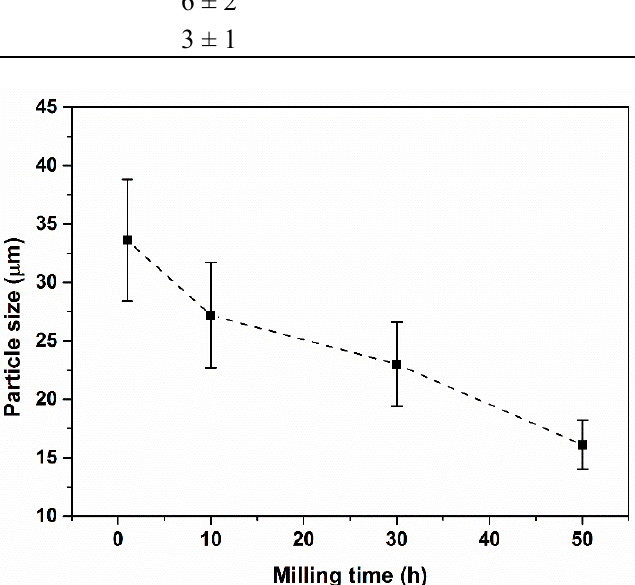
Figure 9. Average particle sizes of the hot pressed composites milled for different